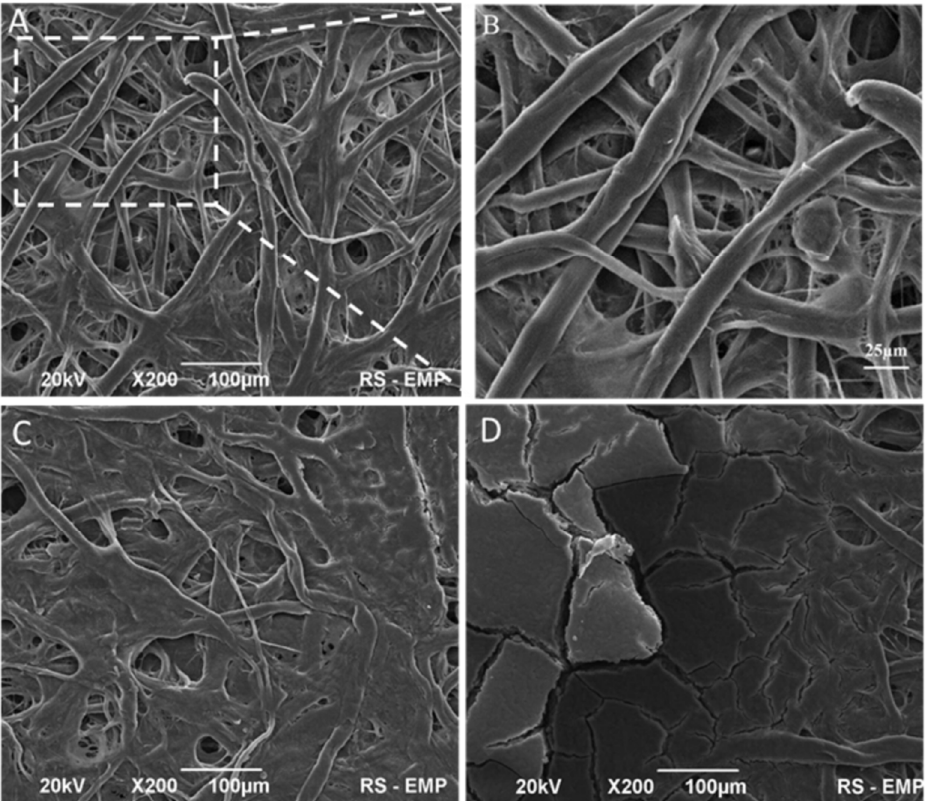
Figure 5. SEM images of cellulose fibers in IMS-50 immunostrip paper before blood testing ( A , B ) and after tests without ( C ) and with ( D ) blood agglutination. Image B is a magnification of cellulose fibers in a selected area of image A.